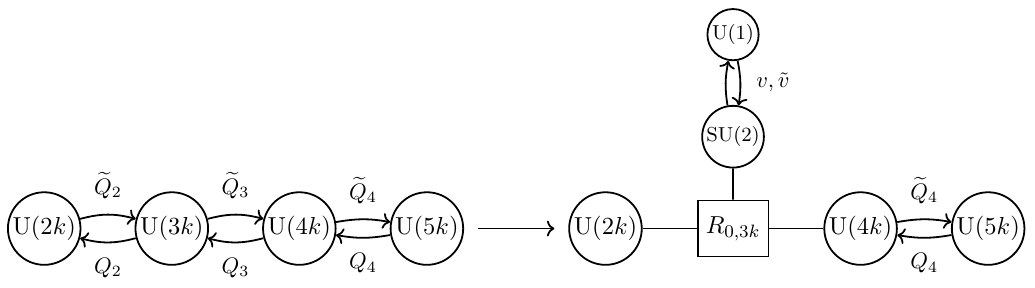
Figure 15 . We replace the U(3 k ) gauge node with non-Lagrangian dual theory in the quiver tail. where v, ˜ v and Φ are the SU(2) doublets and adjoint chiral respectively and φ is the chiral in the abelian 4d N = 2 vector multiplet. Of course the last term is present only if the U(1) symmetry is gauged. The F-term for Φ tells us that the traceless part of ˜ v to ( µ ) β , and the F-term for φ says instead that ˜ v su(2) α implies that µ squares to zero and using (5.11) we reach the desired su(2)